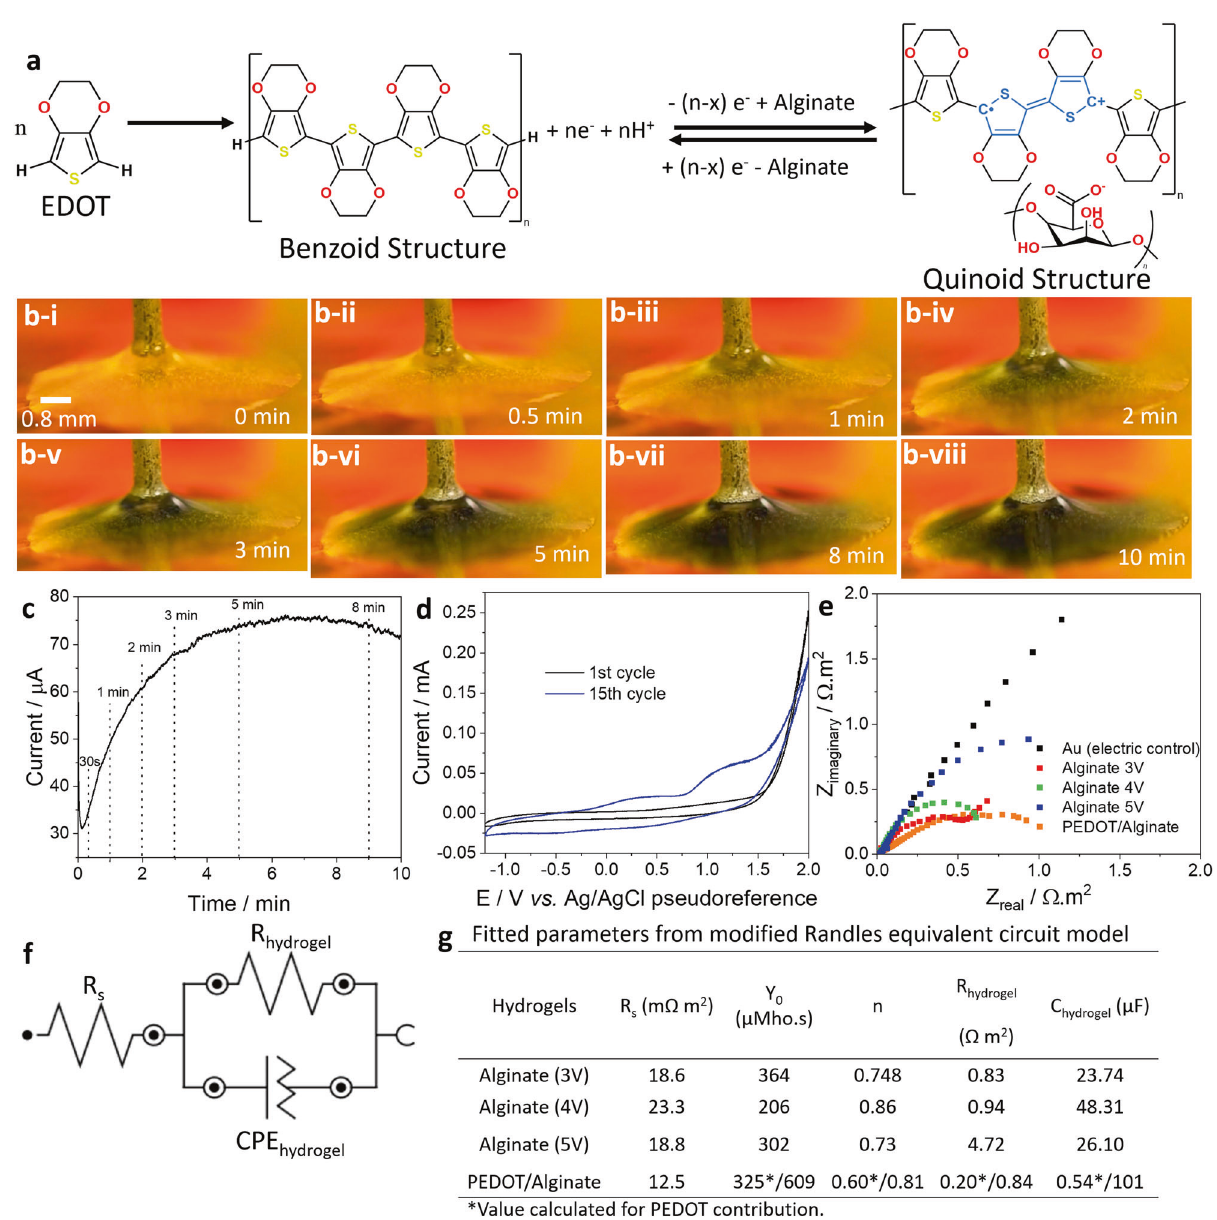
Fig. 4 Hybrid PEDOT/alginate hydrogels and electrochemical characterisation. a Schematic representation of the chemical reactions of EDOT polymerisation (left) and redox changes with alginate as dopant between benzoid and quinoid (blue) structures of PEDOT (right). b Selected frames of PEDOT/alginate electrodeposition. Scale bar 0.8 mm. c CA obtained during PEDOT/alginate polymerisation at + 1.8 V with selected times in dashed line. d 1 st (black) and 15 th (blue) CV cycles in alginate solution with 50 mM EDOT at scan rate of 100 mV s − 1 . e EIS showing Nyquist plot of bare gold surface (black), alginate deposited at 3 V (red), 4 V (green), 5 V (blue) and PEDOT/alginate (orange). The alginate hydrogels were deposited in 60 seconds, while PEDOT/alginate hydrogel took 6 min. f Modi fi ed Randles equivalent circuit used to model the electrical properties of hydrogels, R s indicates solution resistance, R hydrogel is the hydrogel resistance and CPE hydrogel is the constant phase element for the hydrogel. g Equivalent circuit parameters extracted from impedance spectra, where Y 0 is the admittance, n is the deviation from ideal capacitive behaviour and C hydrogel is the capacitance of the hydrogel. Asterisk means the PEDOT contribution to the total